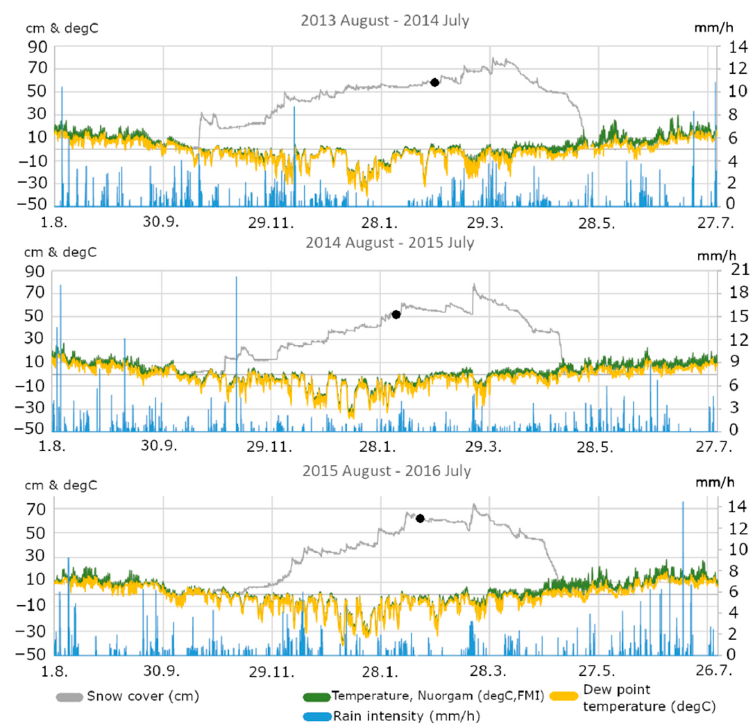
Figure 2. The air temperature, rain intensity and snow depth measured at the FMI’s Nuorgam weather station 2013–2016. The black dots depict the day of snow and ice thickness measurements at the Pulmanki River.